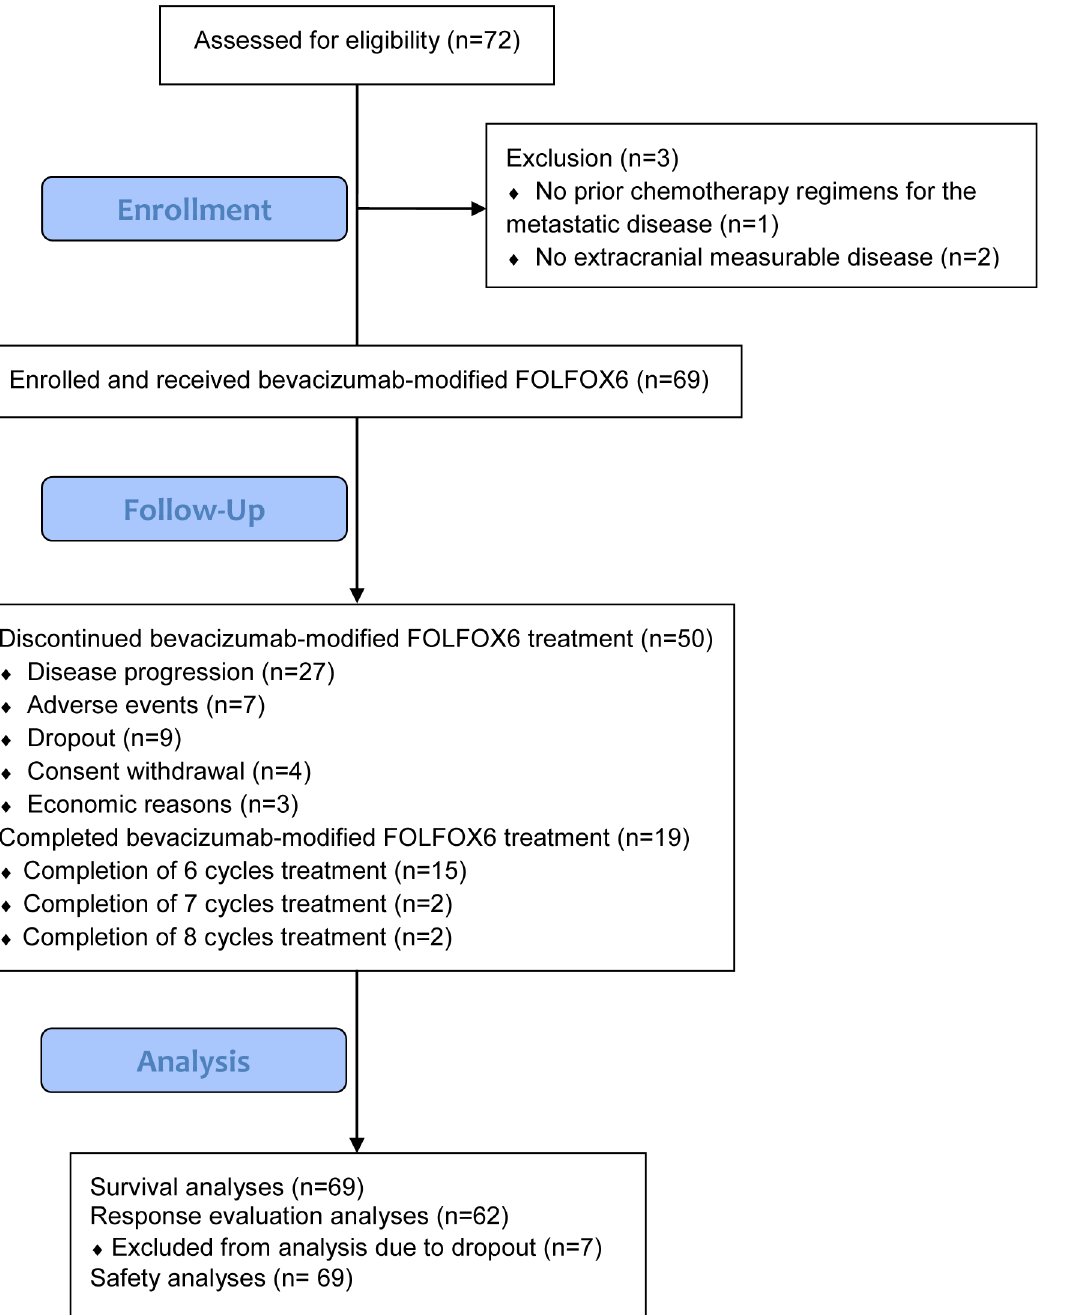
Fig 1. The flow diagram of the present phase II clinical